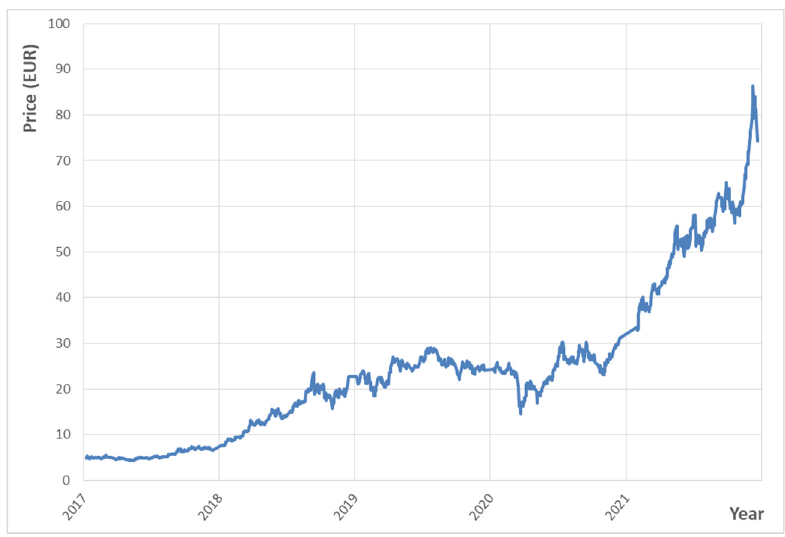
Figure 5. EEX Emissions CO 2 market (average price in EUR)—data source: [23].